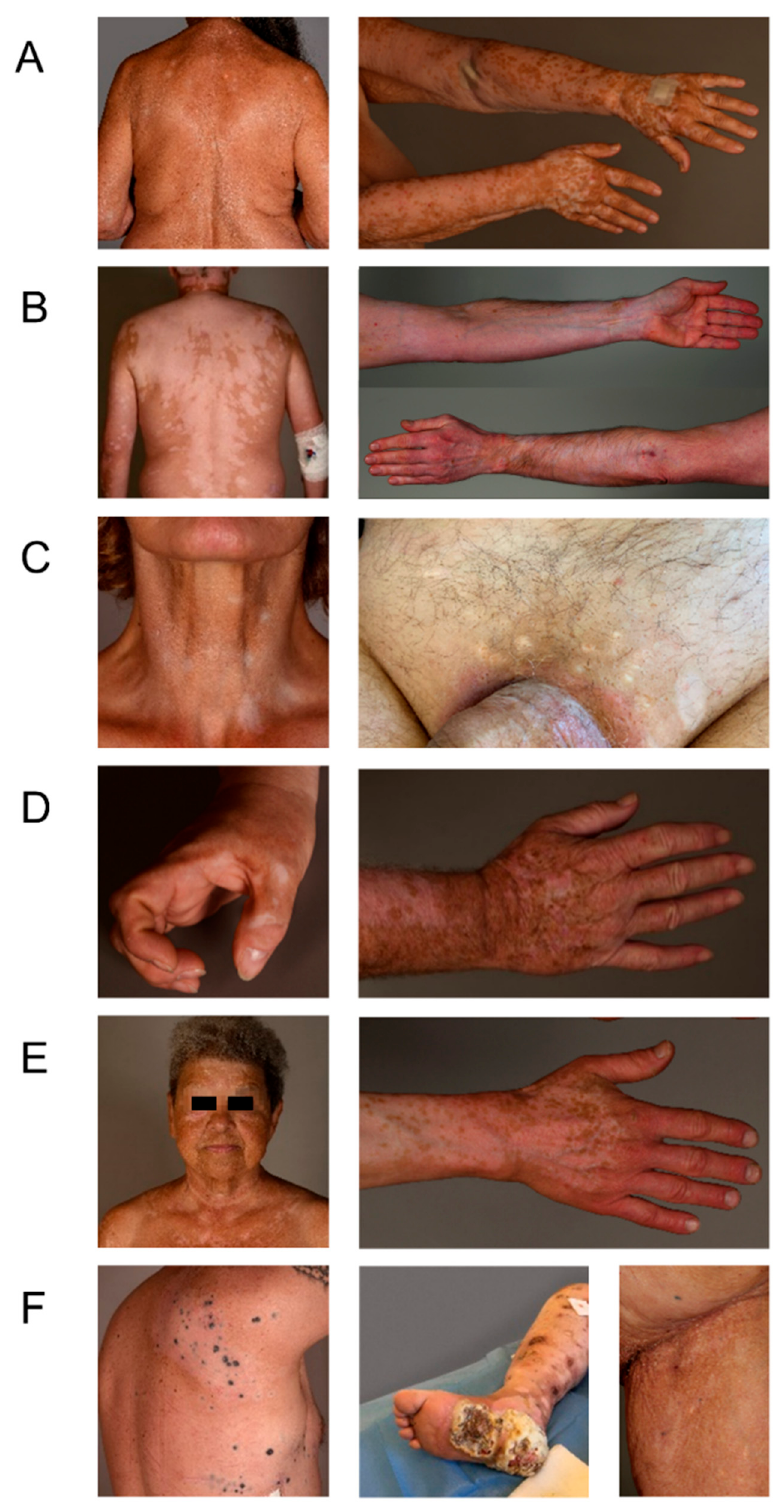
Figure 2. Different VLD patterns. ( A ) Small macule pattern, symmetrical distribution, partly confluent on the arms, representing the most prevalent pattern. ( B ) Large patch pattern, symmetrical distribution, confluent on the back, arms and legs. ( C ) Asymmetrical distribution on the neck and on the groin area. ( D ) Areas with Koebner’s phenomenon. ( E ) Sun-exposed areas without Koebner’s phenomenon. ( F ) Halo phenomenon around cutaneous metastases, asymmetrical pattern.